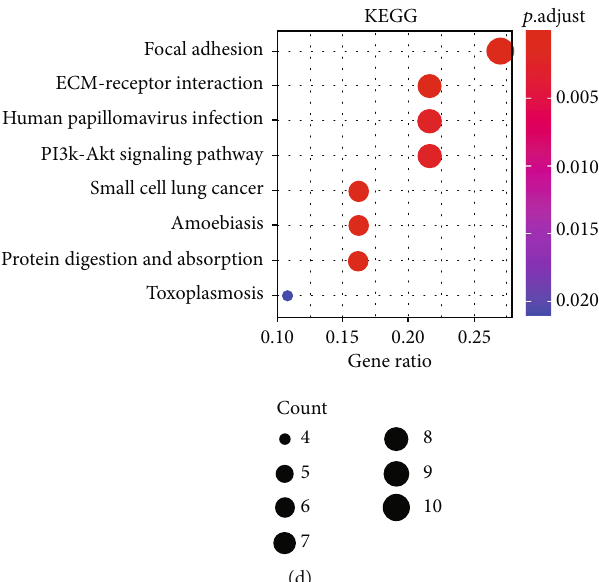
Figure 3: The GO and KEGG analyses ’ results of the di ff erentially expressed and worse-survival-related SMPs: (a) GO: biological process; (b) GO: cellular component; (c) GO: molecular functions; (d)